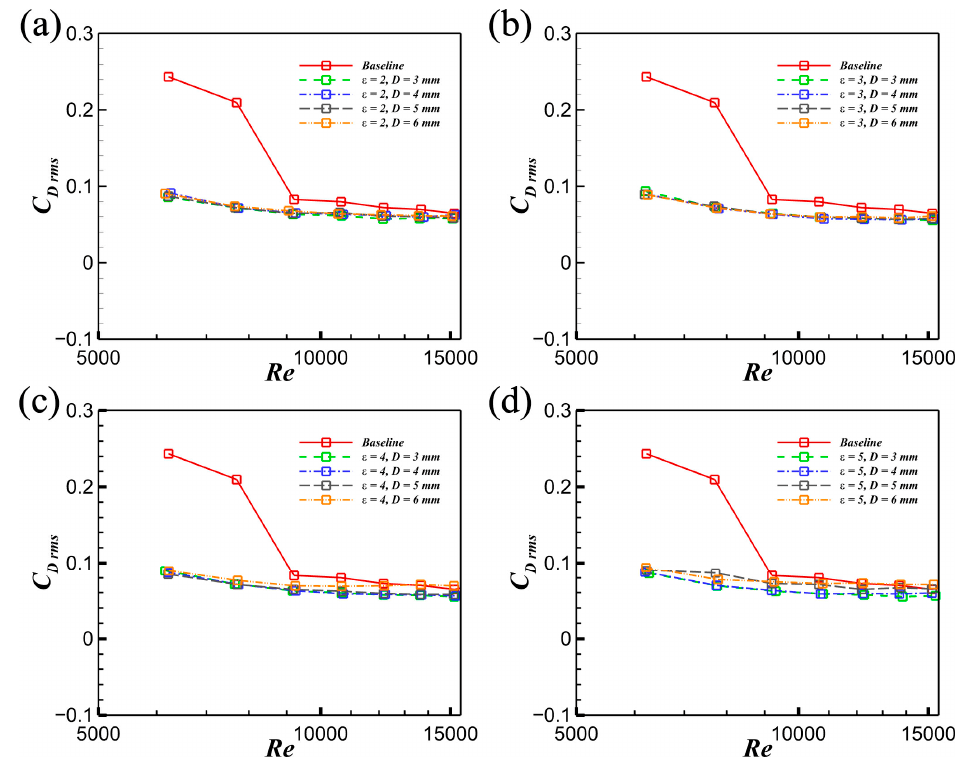
Figure 16. ( a – d ) The relationship between the fluctuating drag force coefficient and the Reynolds number at different spacing ratios and cylinder diameters.